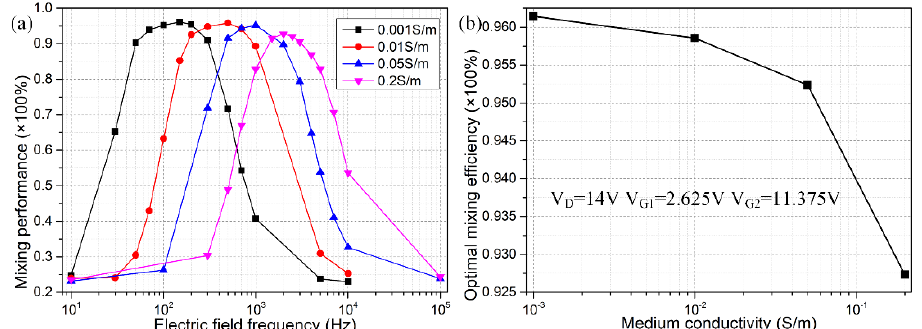
Figure 9. Effect of liquid conductivity on mixing efficiency of the integrated micromixer. ( a ) Frequency-dependent mixing performance for different ionic strength; ( b ) Conductivity-dependent optimum mixing efficiency at corresponding ideal operation frequencies.